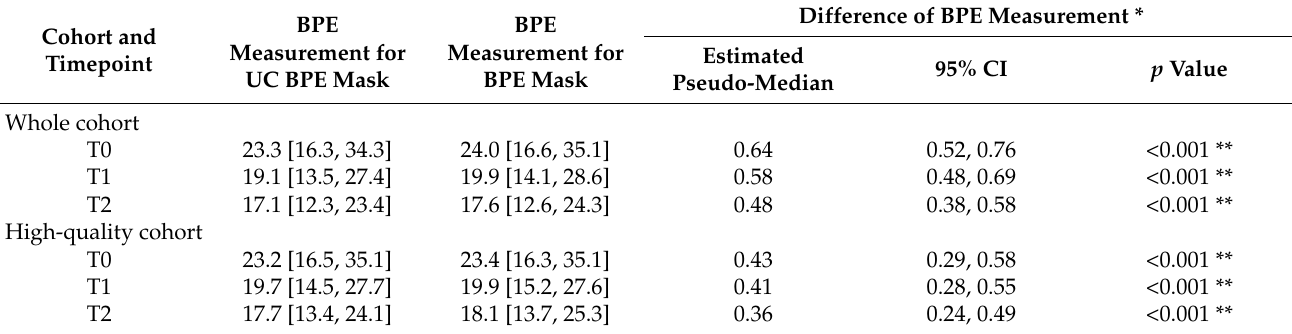
Table 4. BPE measurement before and after bias-correction.